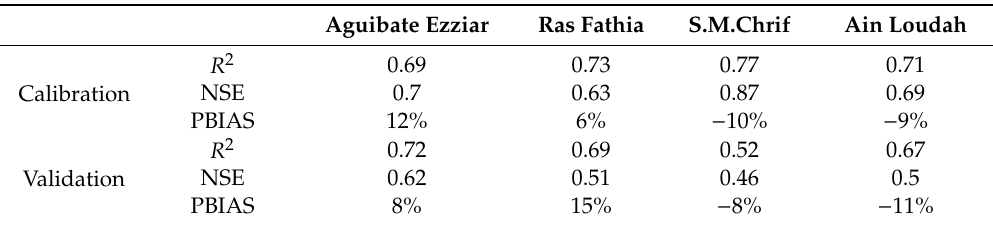
Table 2. R 2 and Nash–Sutcliffe coefficient (NSE) values during calibration and validation at different gauging stations.